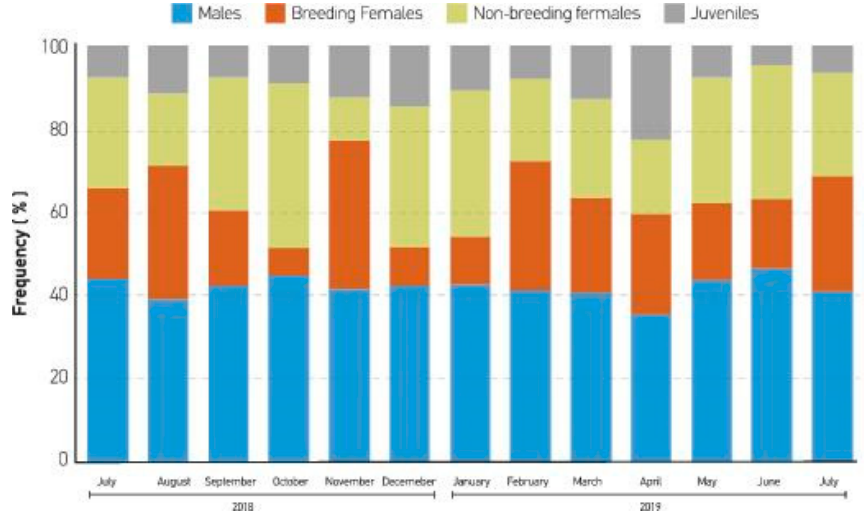
Figure 5. Temporal variation of all demographic categories of Caprella scaura from a fish farm in the Pagasitikos Gulf.